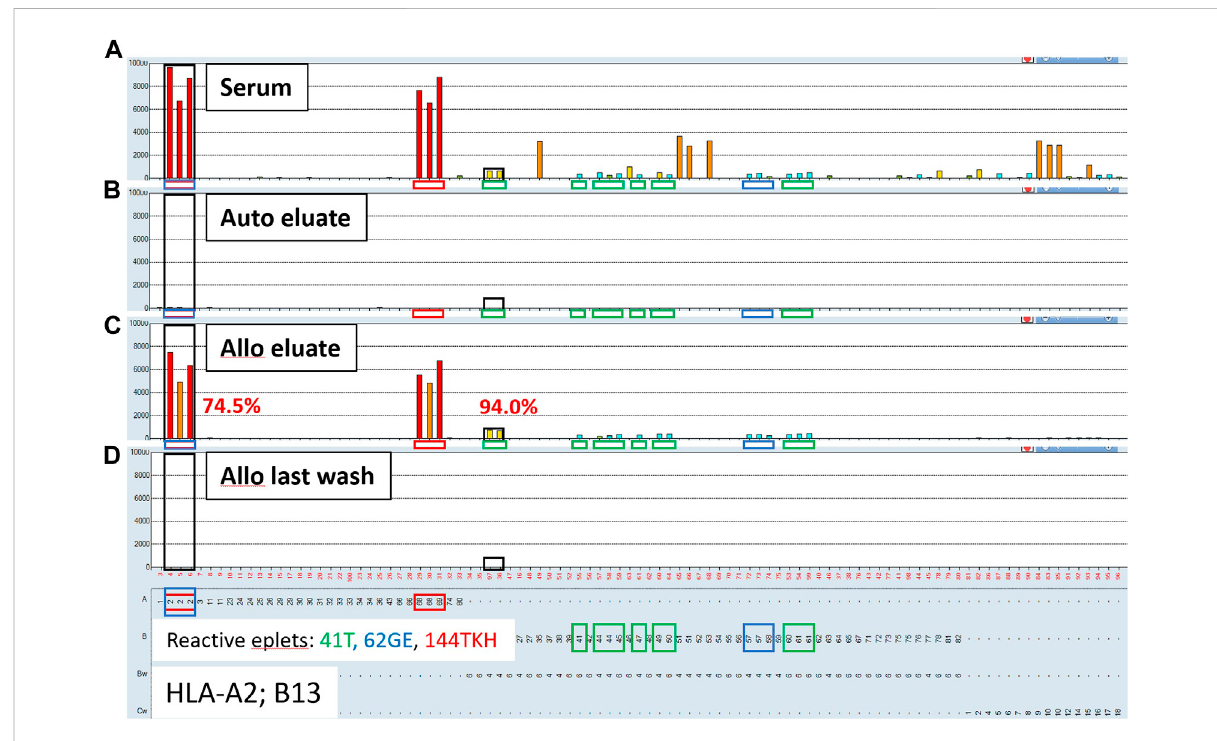
FIGURE 4 Adsorption/elution of HLA antibodies by AXE is donor antigen speci fi c. Representative SAB images of Class I HLA speci fi cities in a sensitized patient ’ sserum (A) ,theAXEeluateusingautologouscells (B) ,theAXEeluateusingallogeneiccells (C) andtheallogeneiccelllastwashcontrol (D) are shown. Mean fl uorescence intensity (MFI) values are displayed on the Y axis. The SAB HLA speci fi cities ( X axis) are sorted in numerical order within each HLA locus (HLA-A, B and C). Bead reactions corresponding to the AXE donor speci fi c antigens (A*02:01 and B*13:02) are highlighted with black rectangles and the antigens are listed at the bottom of panel (D) . The top of each black rectangle aligns with the maximum MFI value in the patient ’ s serum (A) . HLA antigens expressing the mismatched donor 41T, 62GE and 144TKH eplets are highlighted using green, blue and red rectangles, respectively. The ef fi ciency (% MFI compared to serum) of adsorption/elution by AXE using allogeneic cells (C) is indicated with red